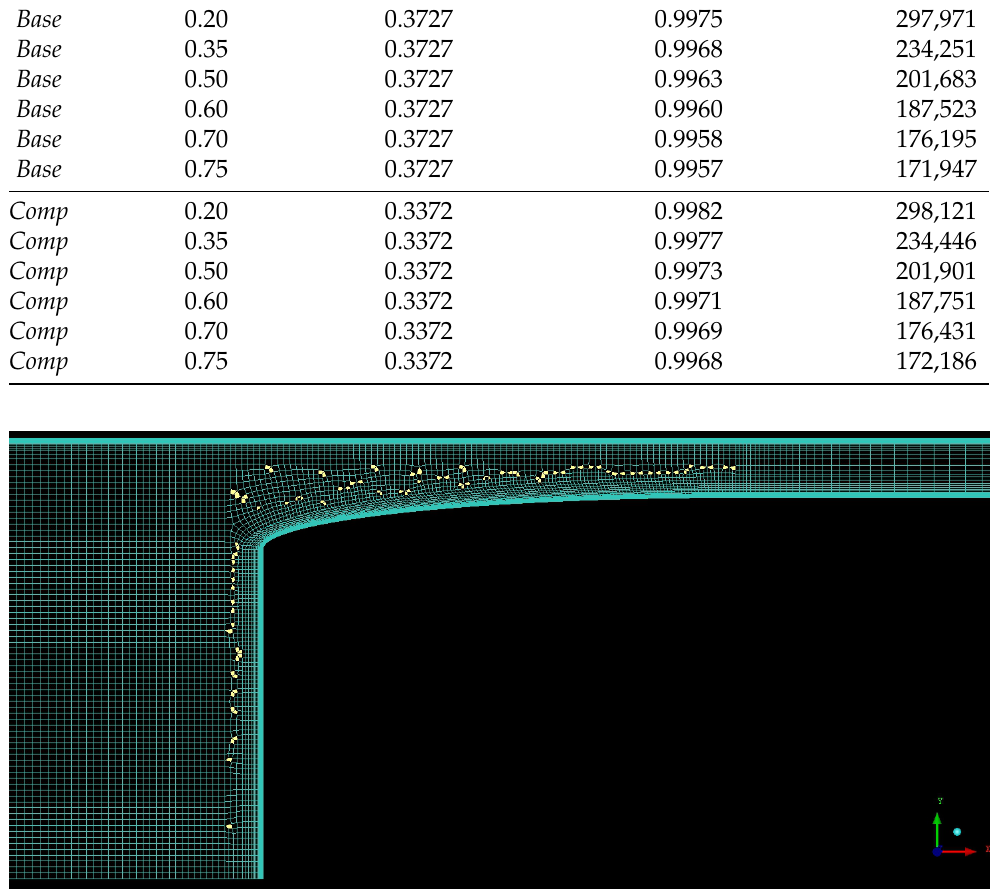
Figure 6. Lowest-quality (<0.5) elements on the compressor case for β =